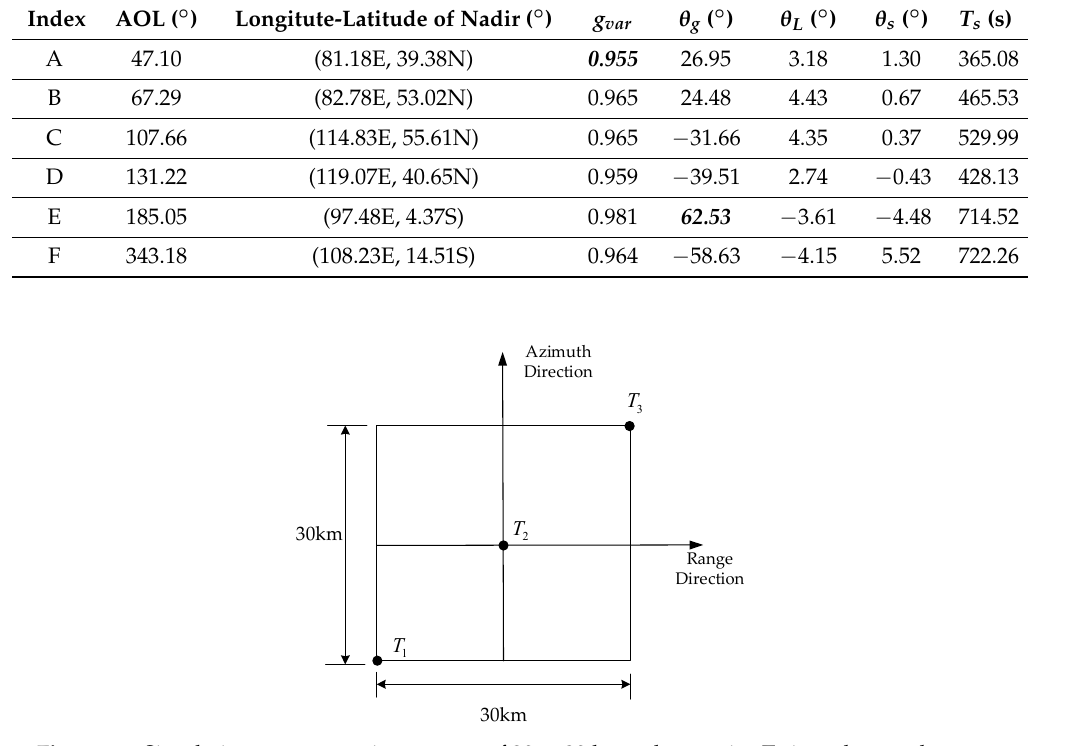
Figure 15. Simulation scene covering an area of 30 × 30 km, where point T 2 is at the swath center.